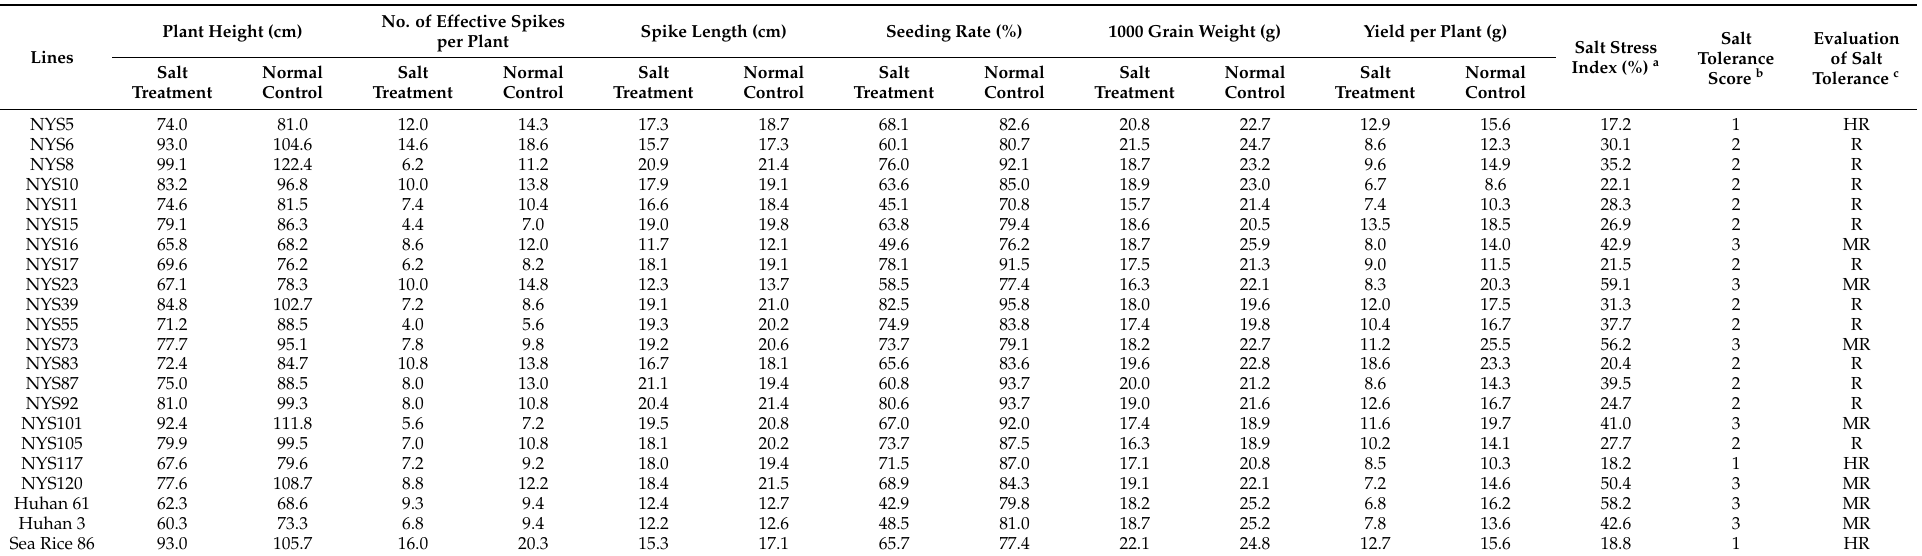
Table 1. Salt-tolerant WDR lines obtained by dominant male sterile recurrent selection